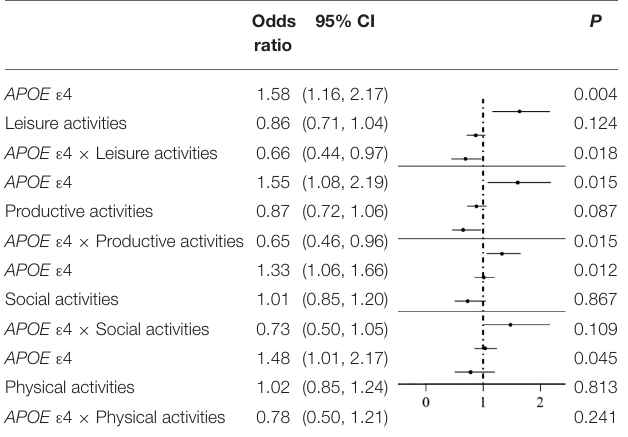
TABLE 3 | Two-way interaction of APOE ε 4, leisure activities, and subtypes of leisure activity on the cognitive decline between 2008 and 2014.